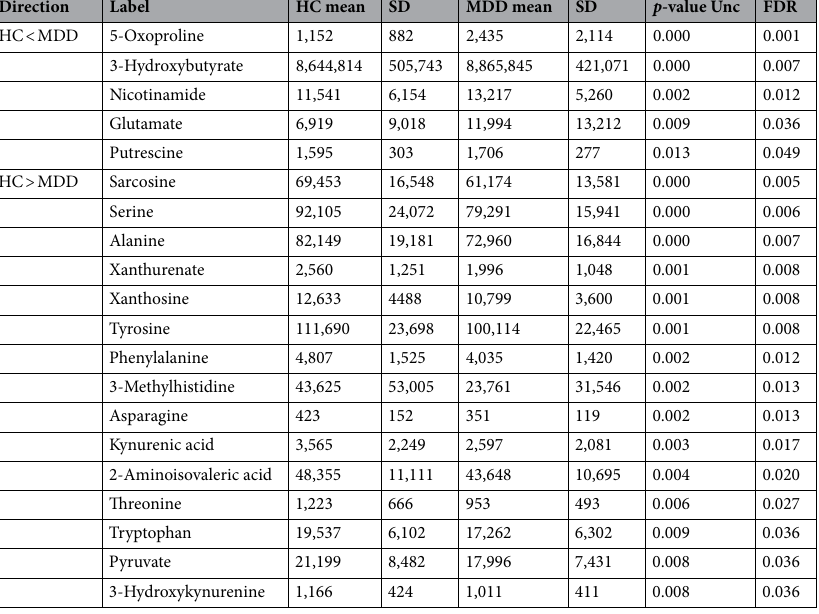
Table 3. Plasma levels of baseline